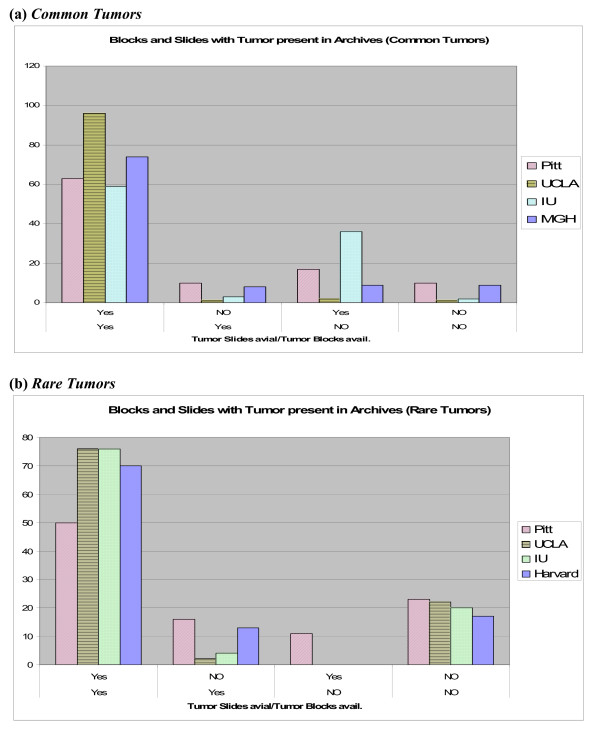
Availability of slides and/or blocks with tumor. Illustration of the availability of slides and/or blocks with the presence of tumor tissue from individual SPIN centers in (a) common tumor cases and (b) rare tumor cases.